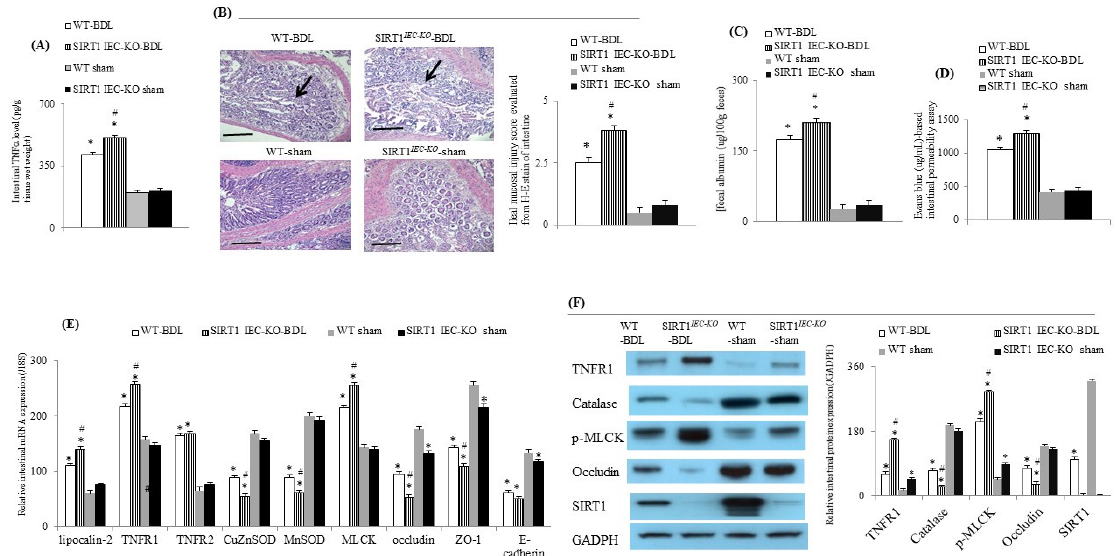
Figure 2. Intestinal SIRT1deficiency aggravates intestinal mucosal injury and barrier dysfunction in BDL-cirrhotic mice. ( A ) Intestinal TNF α level, ( B ) representative images (20 × , the scale bar is 100 µ m) and bar graph of H-E staining for the severity of ileal mucosal injury (arrowhead), ( C ) degree of fecal albumin loss, ( D ) degree of Evans blue-based intestinal barrier dysfunction, ( E ) relative mRNA and ( F ) protein expression of various TNF α -related signals among groups. * vs. WT-sham mice; # vs. WT-BDL mice.